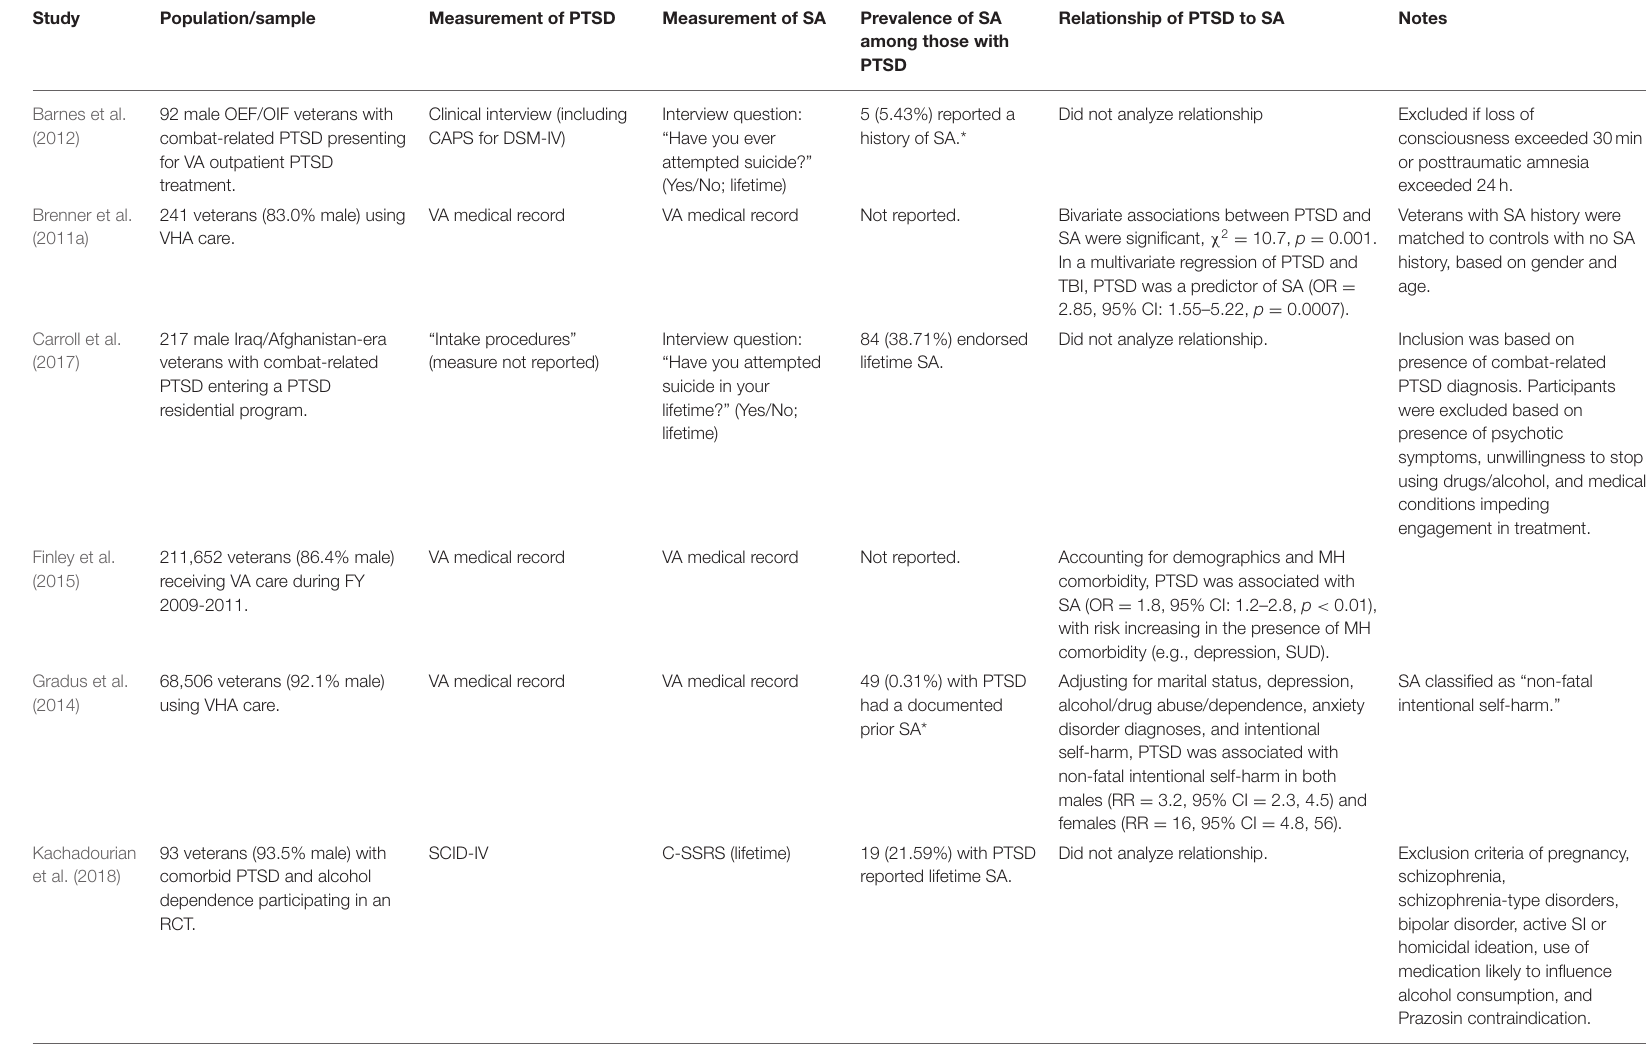
TABLE 3 | SA among Military Personnel and Veterans with PTSD ( n =